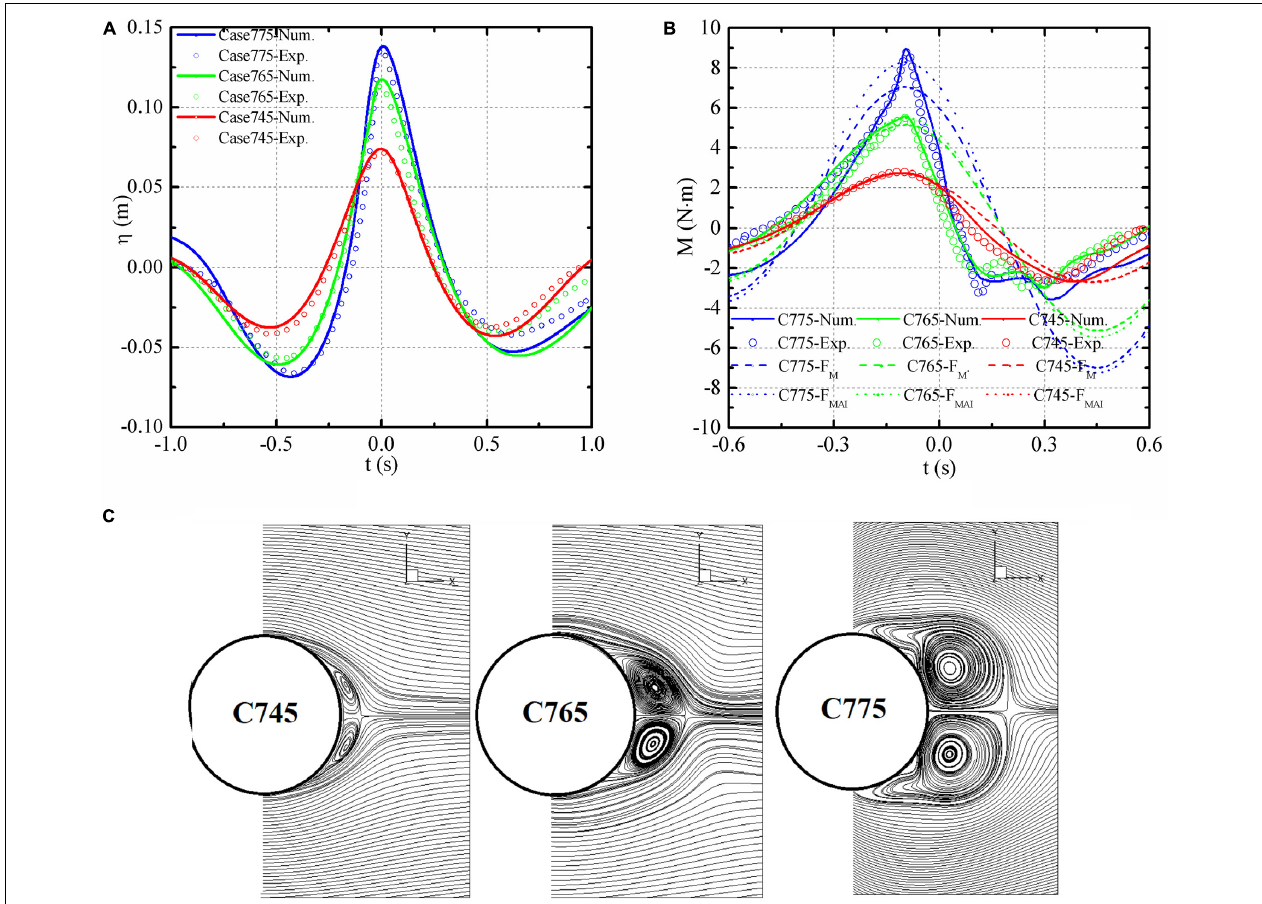
FIGURE 12 | Simulation results for the focused wave cases. (A) Wave elevations, (B) overturning moments, and (C) velocity streamlines at z = 0.425